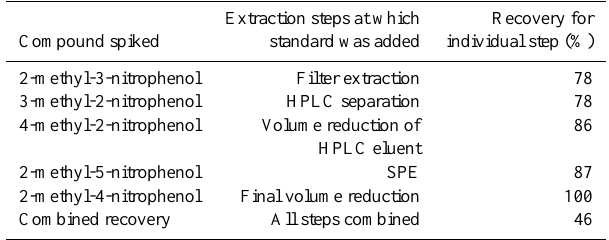
Extraction steps at which Recovery for Compound